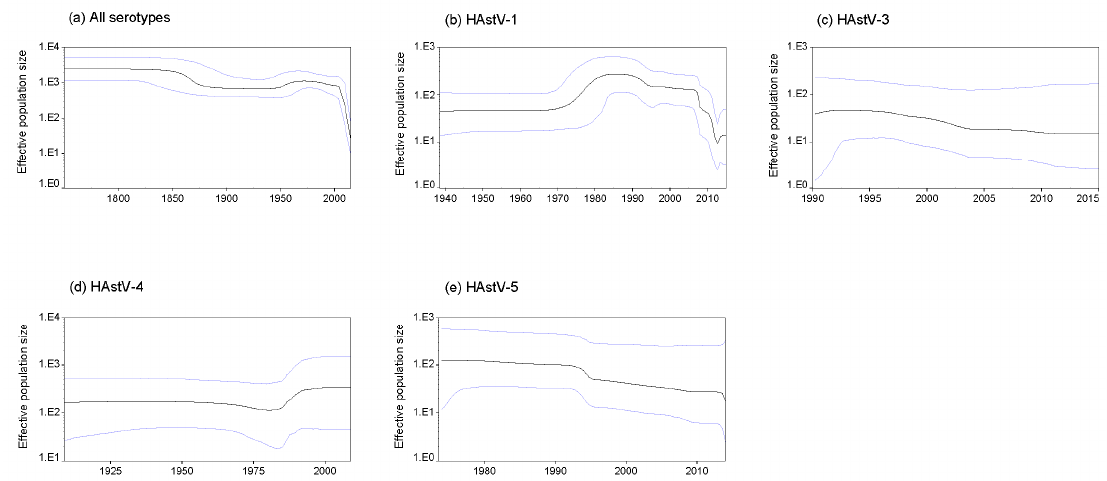
Figure 4. Bayesian skyline plots of the capsid protein gene of classic HAstVs: ( a ) all serotypes, ( b ) HAstV-1, ( c ) HAstV-3, ( d ) HAstV-4, and ( e ) HAstV-5. The Y -axis shows the effective population size. Mean effective population size is shown as a black line. The 95% highest posterior densities are shown as light blue lines.